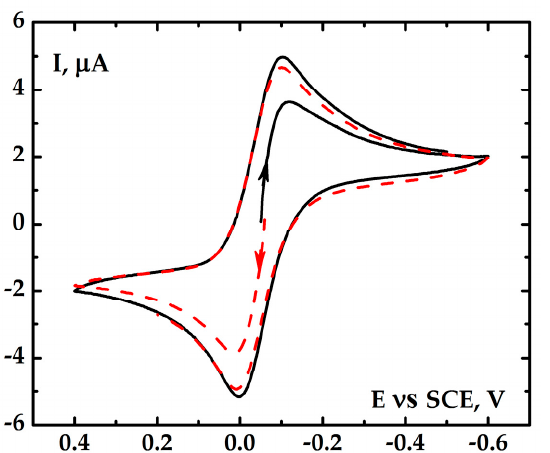
Figure 2. Cyclic voltammograms in acetonitrile (0.1 M Et 4 NClO 4 ) for 5 mM [(salen)Fe II ] MeCN in rigor- ously deoxygenated (by conventional method) solution: The black solid line shows the cathodic, while the red dash line shows the anodic scan, which was recorded first. Scan rate, 0.1 Vs − 1 , GCE (0.008 cm 2 ); SCE vs. NHE, +0.242 V.